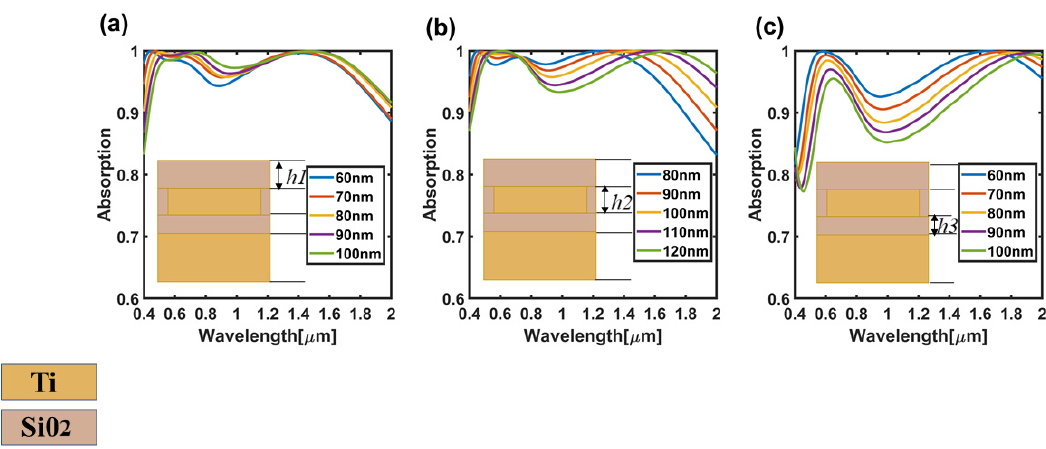
Figure 6. ( a ) Absorption efficiency diagram with only h1 changing from 60–100 nm; ( b ) Absorption efficiency diagram with only h2 changing from 80–120 nm; ( c ) Absorption efficiency diagram with only h3 changing from 60–100 nm.